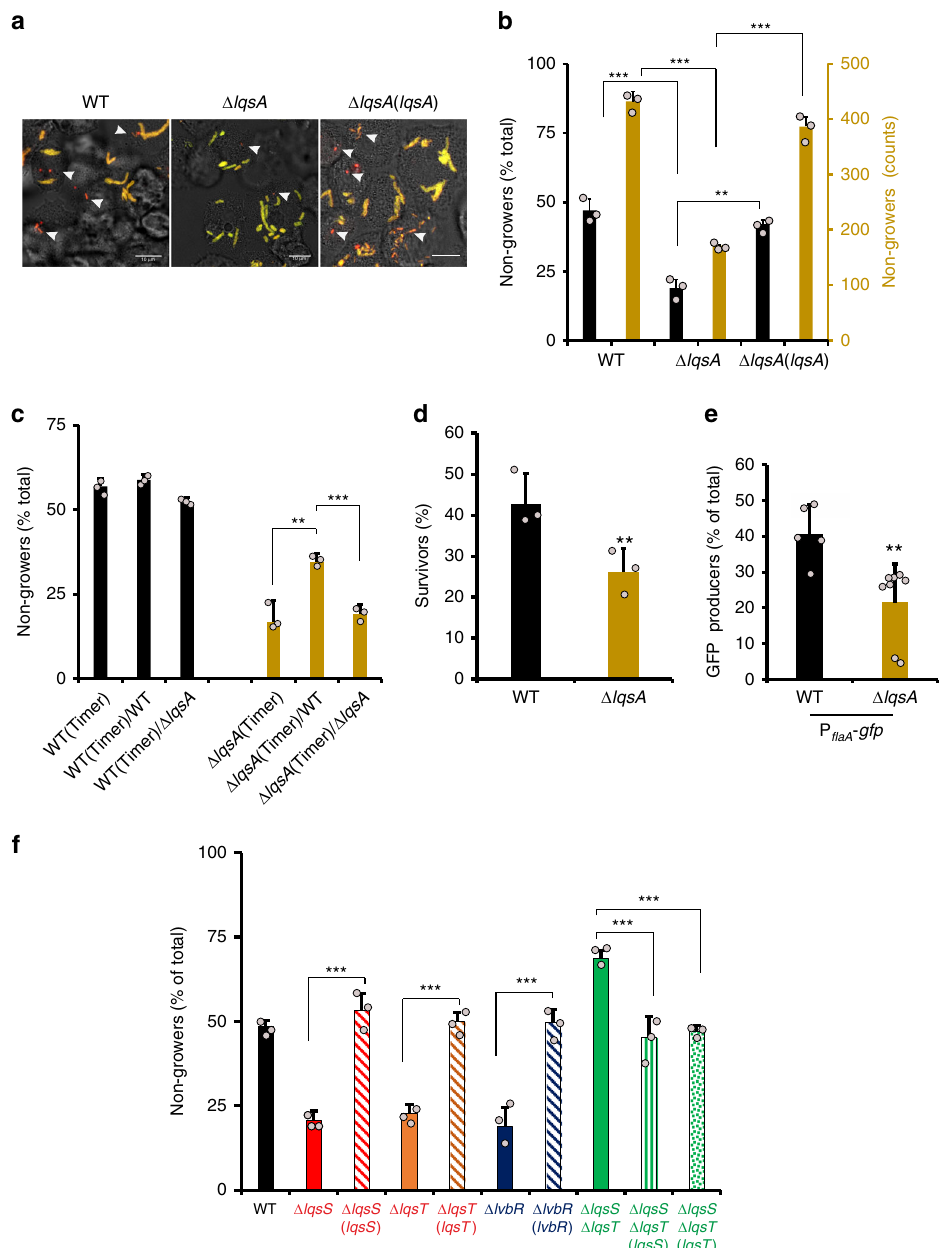
Fig. 7 The Lqs quorum-sensing system controls the formation of intracellular nongrowers. a – c lqsA promotes the formation of intracellular nongrowers. A. castellanii were infected (MOI 1, 24 h) with L. pneumophila WT, Δ lqsA or the complemented strain Δ lqsA ( lqsA ) expressing timer , and ( a ) fi xed and analyzed by confocal microscopy or ( b ) lysed and analyzed by fl ow cytometry. Micrographs show the overlay of bright fi eld and Timer fl uorescence (500 and 600 nm). White arrows indicate intracellular nongrowers. Scale bar 10 μ m. Histograms in black show the subpopulation fraction of intracellular nongrowers (black, left Y -axis) and absolute numbers of nongrowers (NG) in cell lysates are shown (yellow, right Y -axis). c A. castellanii were co-infected (MOI 1, 24 h) with L. pneumophila WT and Δ lqsA (ratio 10:1), expressing timer or not, lysed and the proportion of intracellular nongrowers in lysates was determined by fl ow cytometry. d Deletion of lqsA increases the antibiotic sensitivity of intracellular L. pneumophila . A. castellanii were infected (MOI 1, 24 h) with L. pneumophila WT or Δ lqsA expressing timer , lysed and released bacteria were treated (1 h) or not with of o fl oxacin (3 μ g mL − 1 ). The percentage of surviving bacteria was determined by CFU. e Deletion of lqsA reduces the proportion in intracellular L. pneumophila expressing P fl aA . A. castellanii were infected (MOI 1, 24 h) with L. pneumophila WT or Δ lqsA expressing P fl aA - gfp , lysed and GFP producers were quanti fi ed by fl ow cytometry in lysates of infected amoebae. f The Lqs quorum-sensing system controls the formation of intracellular nongrowers. A. castellanii was infected (MOI 1, 24 h) with L. pneumophila WT, the isogenic Δ lqsS , Δ lqsT , Δ lqsS - Δ lqsT , or Δ lvbR mutant strains and the complemented strains Δ lqsS ( lqsS ), Δ lqsT ( lqsT ), or Δ lvbR ( lvbR ), Δ lqsS - Δ lqsT ( lqsS ), Δ lqsS - Δ lqsT ( lqsT ), expressing timer . After host cell lysis, the fraction of nongrowers was determined by fl ow cytometry. Data represent the mean ± SEM of at least three biological replicates ( n ≥ 3; light gray fi lled circles). Student ’ s t test two-tailed. *** P < 0.001, ** P < 0.01. Source data are provided as a Source Data fi